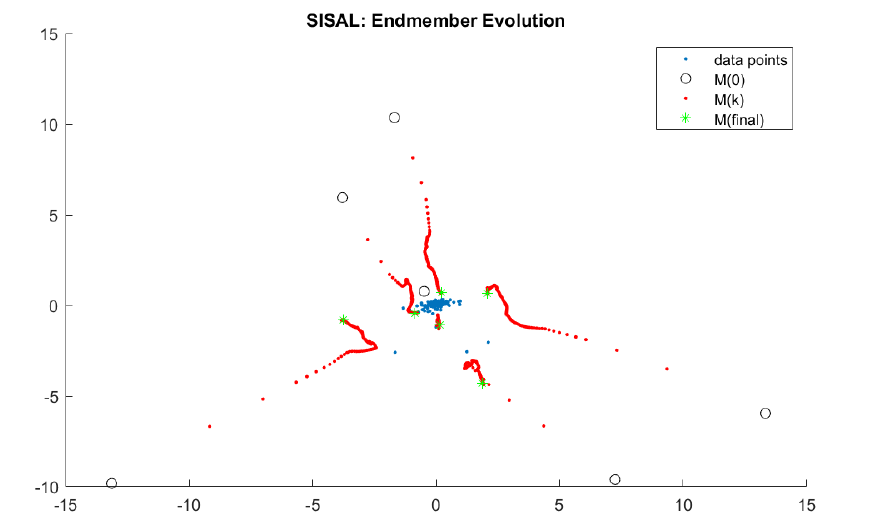
Figure 7. Locations of endmembers extracted from algorithms working under the pure pixel assumption on the Large Targets subset using as input number of endmembers k = 6.